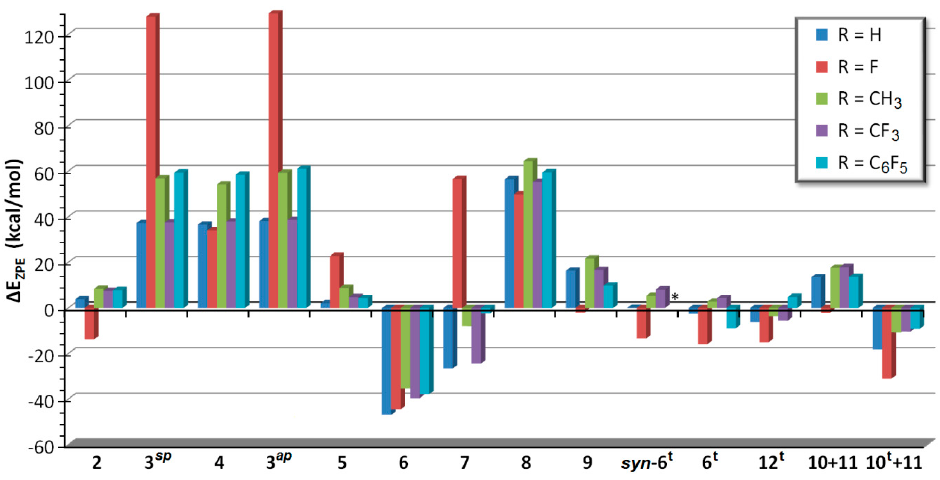
Figure 5. Computed (CCSD(T)/def2-TZVPP//B3LYP-D3/def2-TZVP) zero-point corrected relative